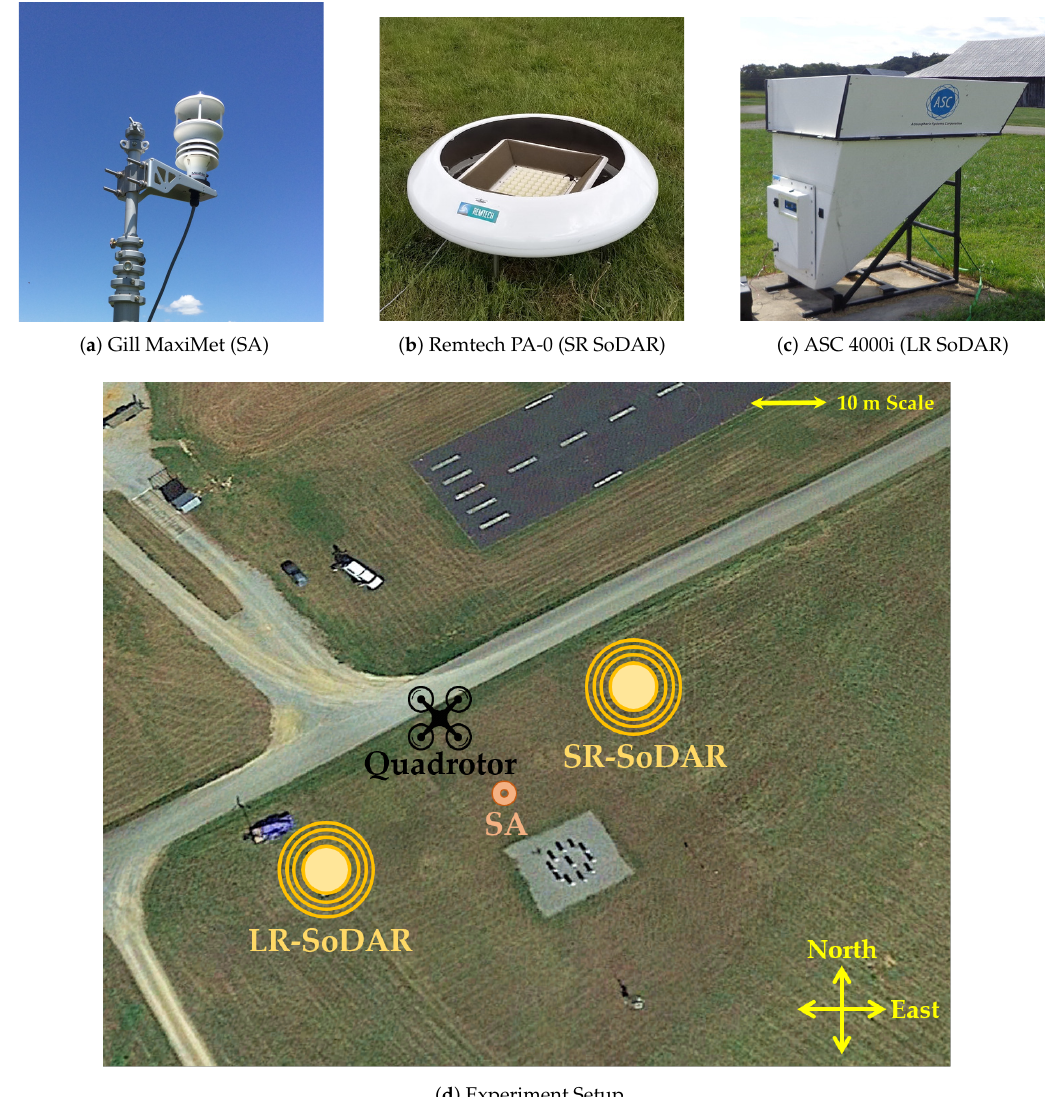
Figure 4. ( a ) The Gill MaxiMet sonic anemometer used to measure wind velocity 10 m AGL. ( b ) The Remtech PA-0 sensor (SR SoDAR) used to measure wind velocity from 10 to 120 m AGL. ( c ) The ASC 4000i sensor (LR SoDAR) used to measure wind velocity from 30 to 120 m AGL. ( d ) The experiment setup used to validate quadrotor wind estimates from 10 to 120 m